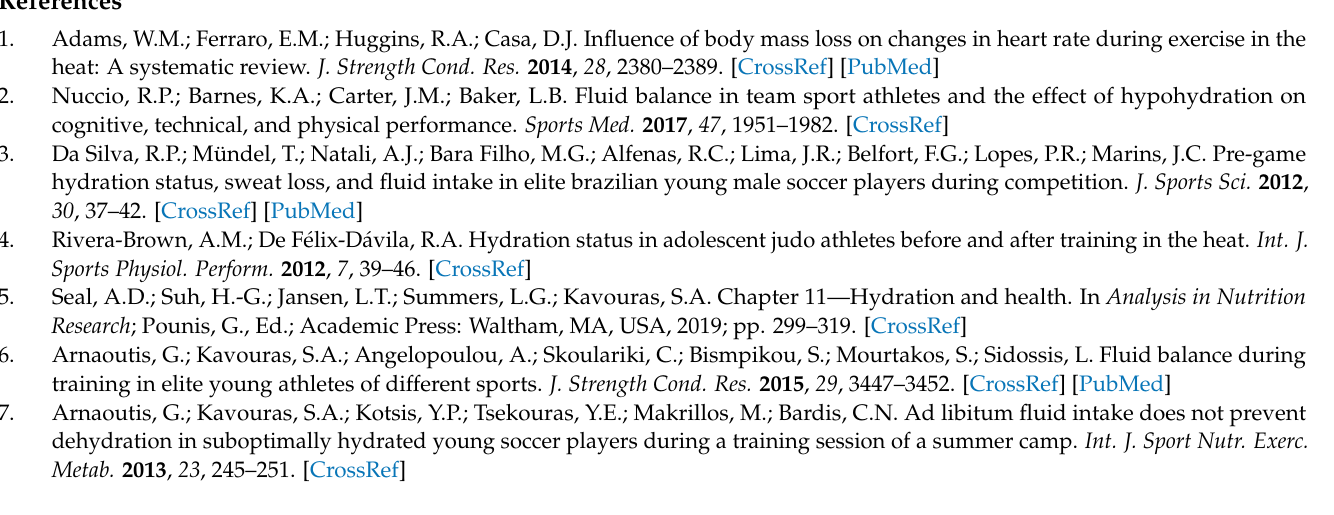
training measures, Table S2.1: Pairwise comparison between sports for sweat rate, Table S2.2: Pairwise comparison between sessions for sweat rate, Table S2.3: Pairwise comparison between sports for fluid consumption rate, Table S2.4: Pairwise comparison between sessions for fluid consumption rate, Table S3.1: Main effect of sport on percentage body mass change, Table S3.2: Pairwise comparison between sports for percentage body mass change, Table S4.1: Main effects of gender on sweat rate and percentage body mass change, Table S4.2: Pairwise comparison between genders for sweat rate, Table S4.3: Pairwise comparison between genders for percentage body mass change, Table S5.1: Main effect of pre-training USG hydration classification on fluid consumption rate, Table S5.2: Pairwise comparison between pre-training USG hydration classification for fluid consumption